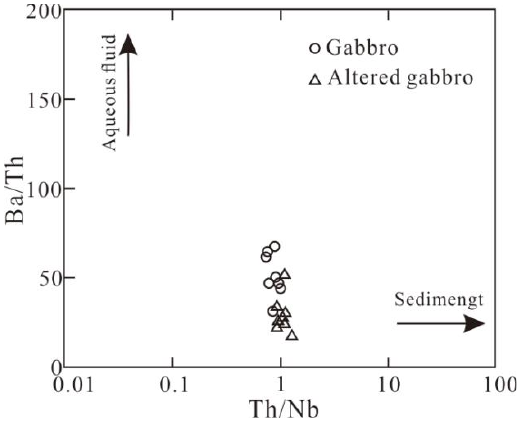
Figure 9. Ba/Th versus Th/Nb discrimination diagram for Ping’an gabbros.